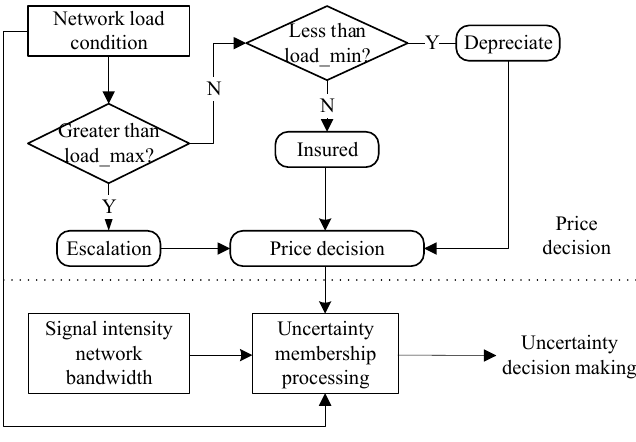
Figure 5. The network pricing controlling process.